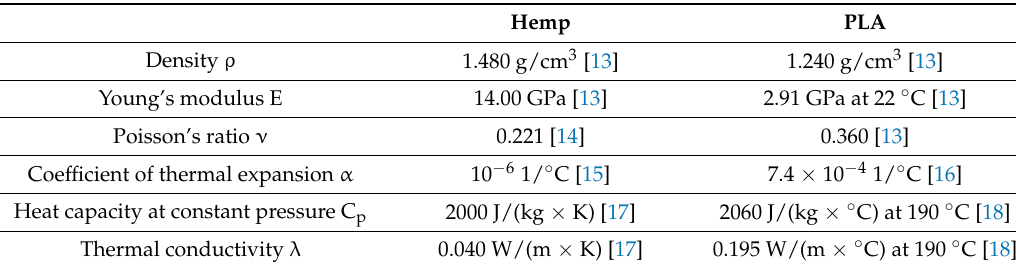
Table 1. Material properties for the FE simulation.